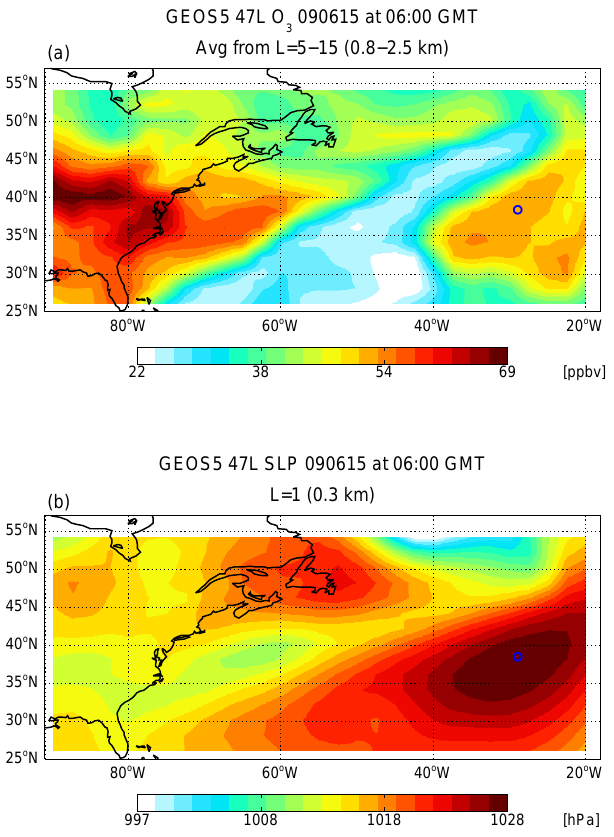
Fig. 9. GEOS-Chem-simulated ozone mixing ratio averaged from 0.8 to 2.5km altitude (a) and surface pressure (b) at the arrival time of event 2 (15 June 2009, 06:00UTC). The location of Pico Moun- tain Observatory is indicated with a blue